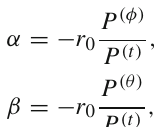
potential seen here, we confirms the repulsive nature of the quintessential dark energy. It further indicates that the CS can also have repulsive nature in the spacetime of the KNKL black